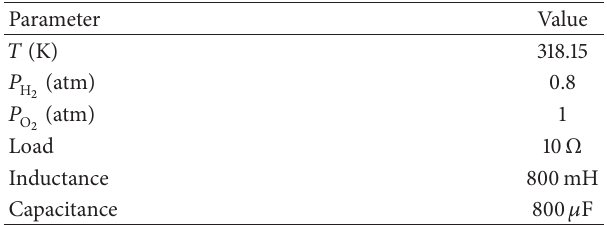
Table 1: Parameters of fuel cell system and DC-DC